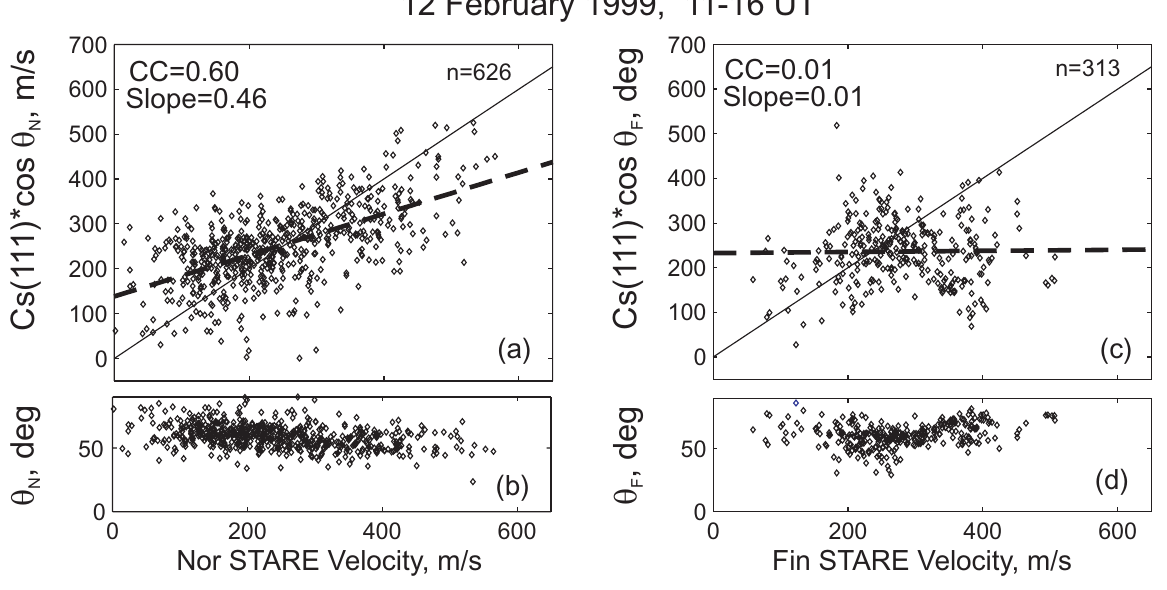
Fig. 1. (a) and (c) : A comparison of the predicted and measured velocity for the Norway and Finland STARE observations over the EISCAT spot for 12 February 1999. For predictions, the irregularity phase velocity was assumed to be the line-of-sight component of the ion-acoustic speed C S at 111km. Panels (b) and (d) present the flow angles of observations for the Norway and Finland radars, respectively. The correlation coefficients and the slopes of the best linear fit line are given in the top left part of plots (a) and (c). The number n is the total number of points involved in respective